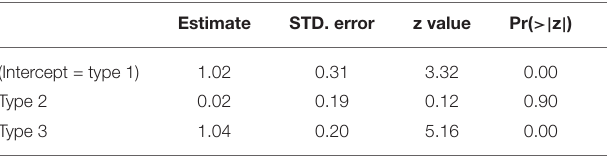
TABLE 11 | Logistic regression analysis of the accuracy of the judgements of the participants to nonces in experiment 2.